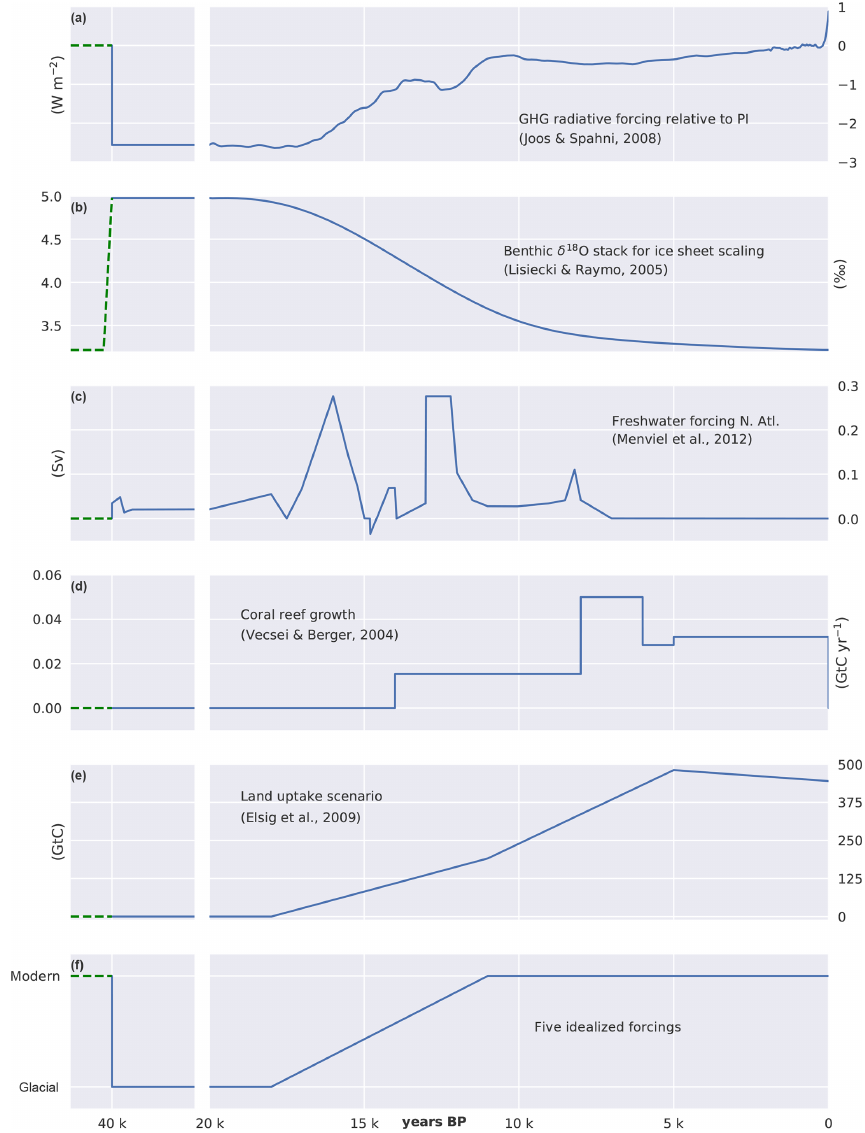
Figure 3. Forcings applied for the LGM to PI simulations. (a) Radiative forcing imposed by CO 2 , CH 4 , and N 2 O, (b) benthic δ 18 O used to scale ice sheet extent, (c) freshwater forcing into the North Atlantic, and (d) coral reef regrowth as applied as standard transient forcing. (e) Prescribed evolution of land biosphere carbon uptake. Cumulative land biosphere uptake is varied over the termination across factorial simulations but kept invariant (254GtC) over the Holocene (11–0ka) following Elsig et al. (2009); here a scenario with a total uptake of 445GtC is shown for illustration. (f) Idealized evolution of scaling factors as prescribed in factorial experiments to vary the remineralization profile, rain ratio, Southern Ocean wind stress and gas transfer rate, or organic weathering flux on land between LGM and PI values. The freshwater forcing in the North Atlantic is varied over 40kyr. Dashed green lines indicate spin-up